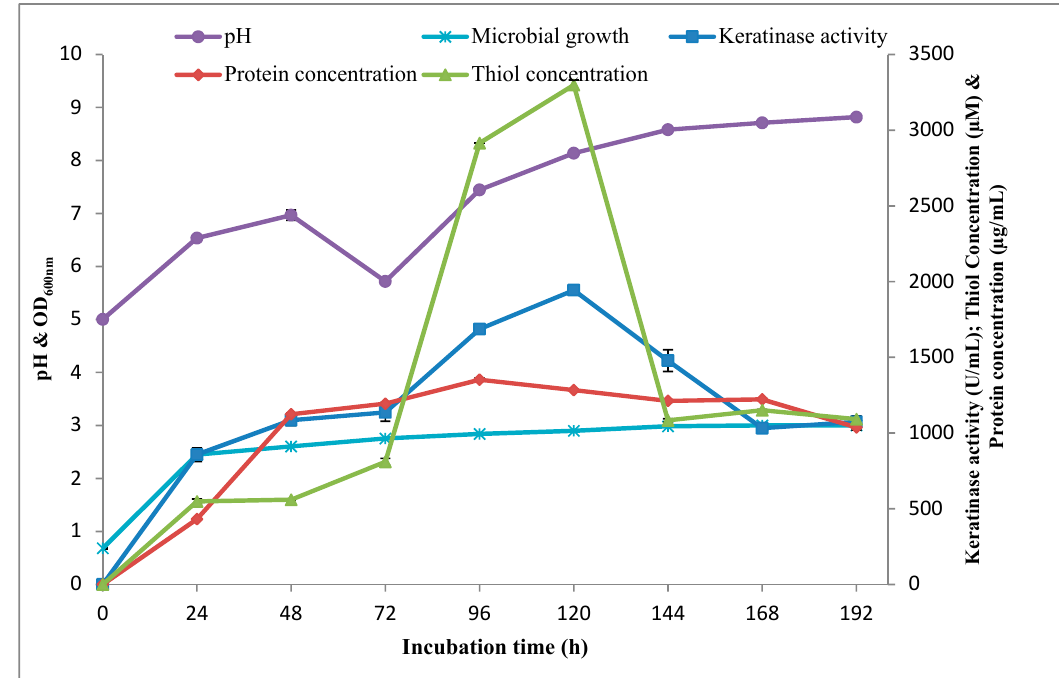
Figure 4. Time course profile of keratinolytic activity by Bacillus sp. Nnolim-K1 in an improved basal feather medium at 25 °C and 150 rpm. Each point represents the mean value of triplicate experiments.